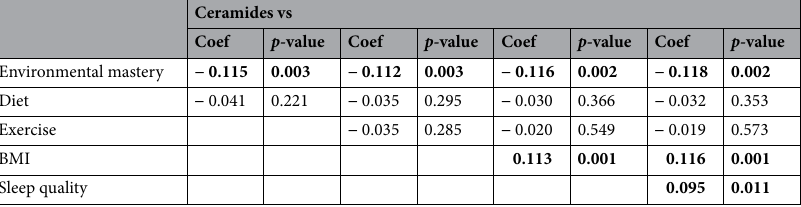
Table 3. Multivariate association analysis between environmental mastery and ceramides considering the effect of health behaviors. p -values < 0.05 and their standardized regression coefficients are denoted in bold.